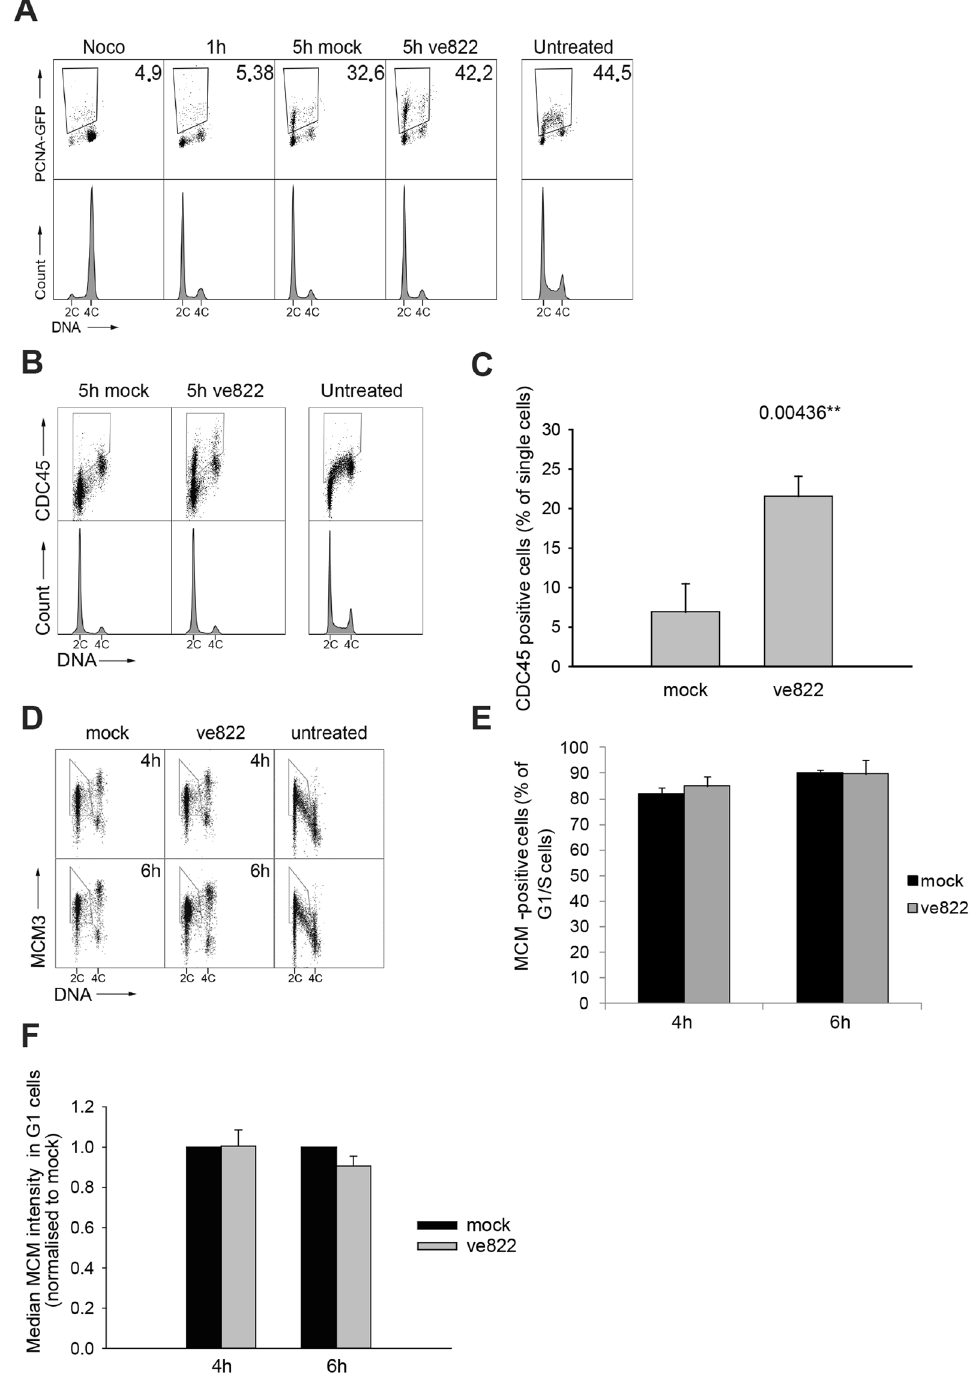
Figure 4. Chromatin loading of replication initiation factors after ATR inhibition in G1 phase ( A ) Dot plots showing DNA content versus intensity of chromatin-bound PCNA-GFP in individual U2OS cells at the indicated time points after release from nocodazole-induced mitotic arrest. Cells arrested and 1 h after release were used as negative controls to determine the region of interest. ATRi ve822 (160 nM) or mock (DMSO) was added 1 hour after release from the mitotic arrest. The staining for flow cytometry of arrested, 1 hour, 5 hour mock and 5 hour ve822 samples was performed in the same barcoding set. Numbers show the percentage of PCNA-GFP positive cells. The pattern of chromatin-bound PCNA-GFP in exponentially growing cells is shown for comparison. DNA histograms of each time point are shown for reference. ( B ) Dot plots showing DNA content versus intensity of chromatin-bound CDC45 in individual U2OS cells at the indicated time points after release from nocodazole-induced mitotic arrest. ATRi ve822 (160 nM) or DMSO (mock) was added 1 hour after release from the mitotic arrest. The samples shown were stained with antibodies in the same barcoding set. Supplementary Fig. S5 B shows how the CDC45-positive cells were identified. ( C ) Quantification